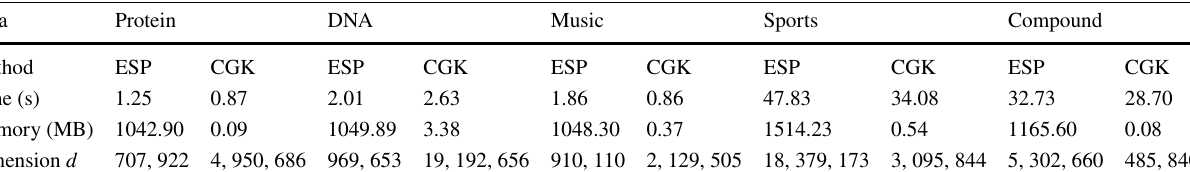
Table 3 Execution time in seconds, memory in mega bytes and dimension d of characteristic vectors by ESP and CGK for each dataset